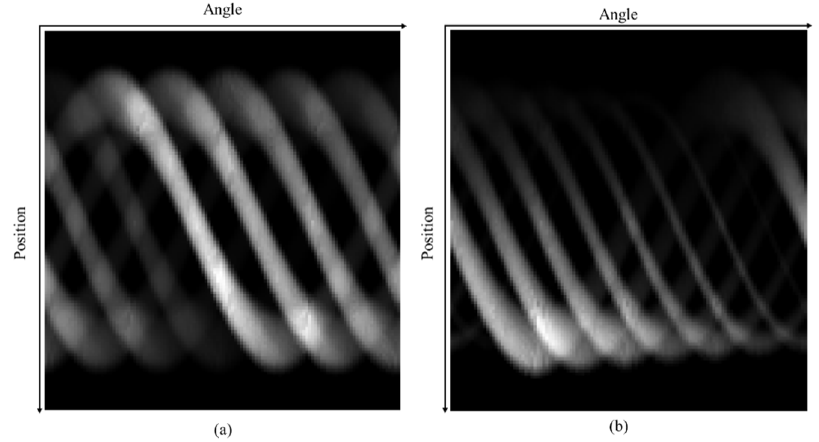
Figure 6. The sinograms acquired by numerical simulation. ( a ) is the sinogram of phantom A and ( b ) is the sinogram of phantom B .